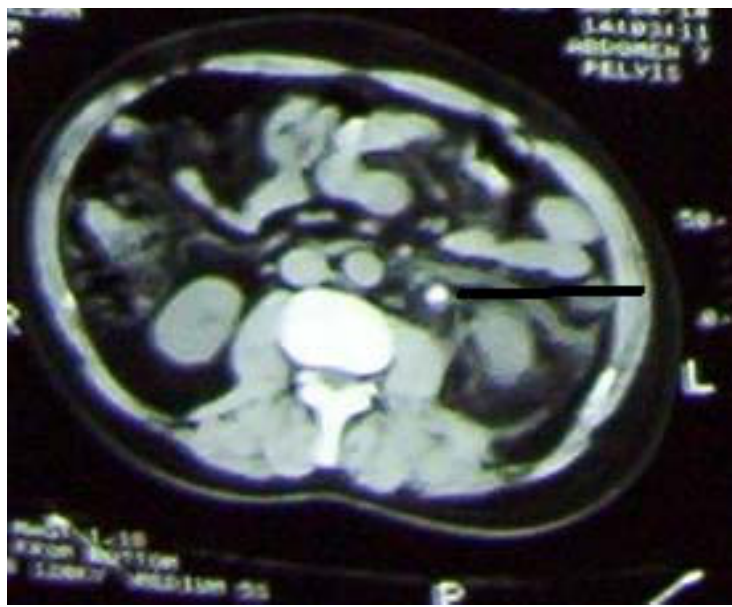
FIGURE 4. Unenhanced CT (4/17/06). Ureteral lithiasis (8 mm) (black